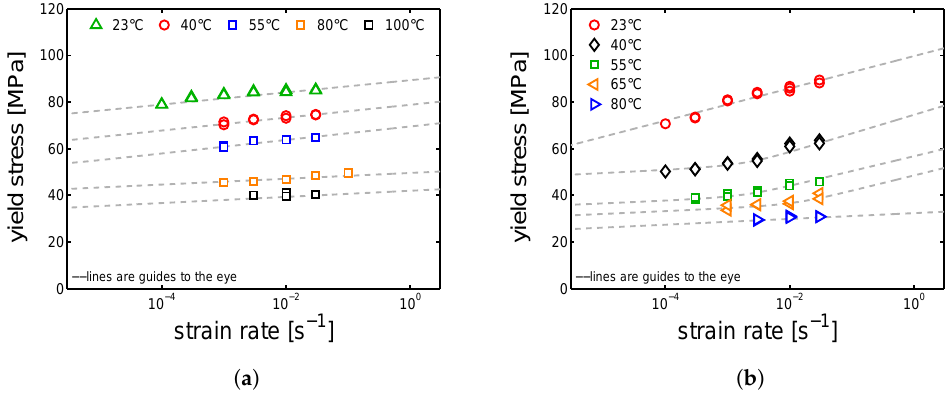
Figure 5. Yield kinetics (yield stress versus strain rate) at different temperatures for the ( a ) α -I and ( b ) γ -I samples. Lines are guides to the